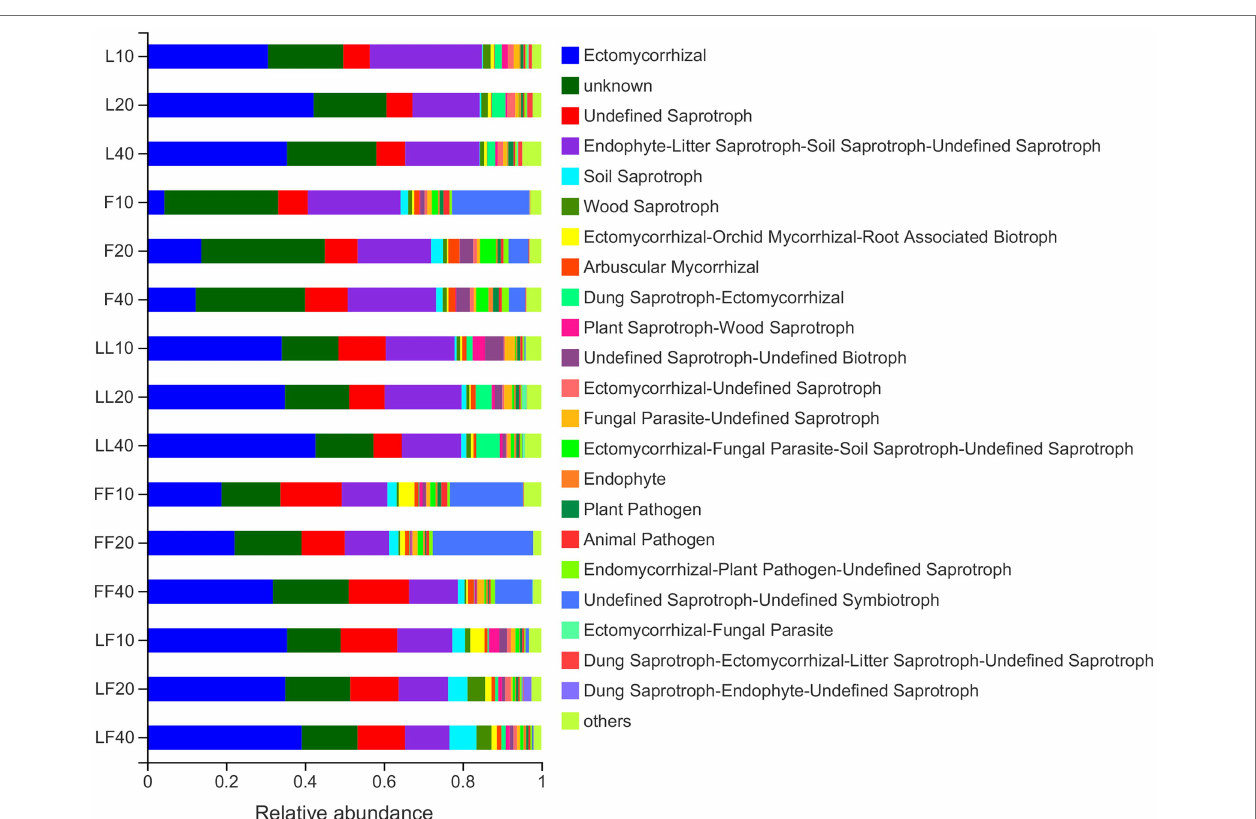
FIGURE 6 | Variations in fungal functional group compositions inferred by FUNGuild. Refer to Figure 1 legend for relevant